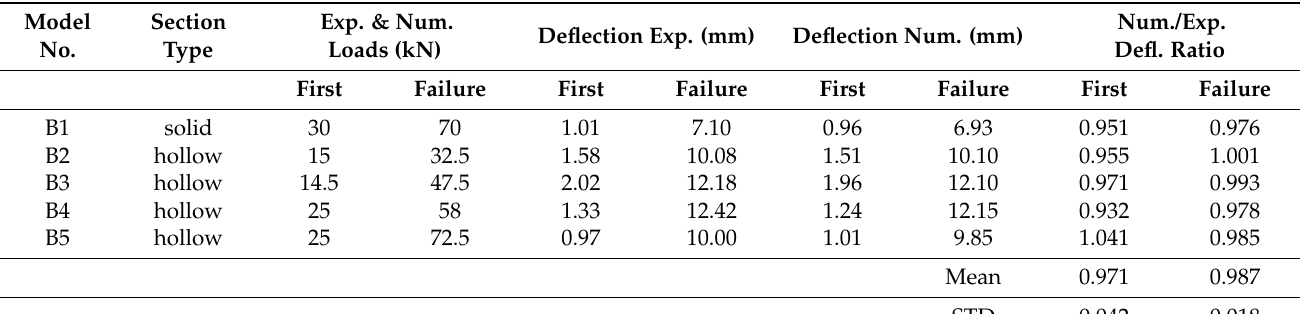
Table 5. Comparison of the experimental and numerical results of the mid-span deflections of the RC beam models.